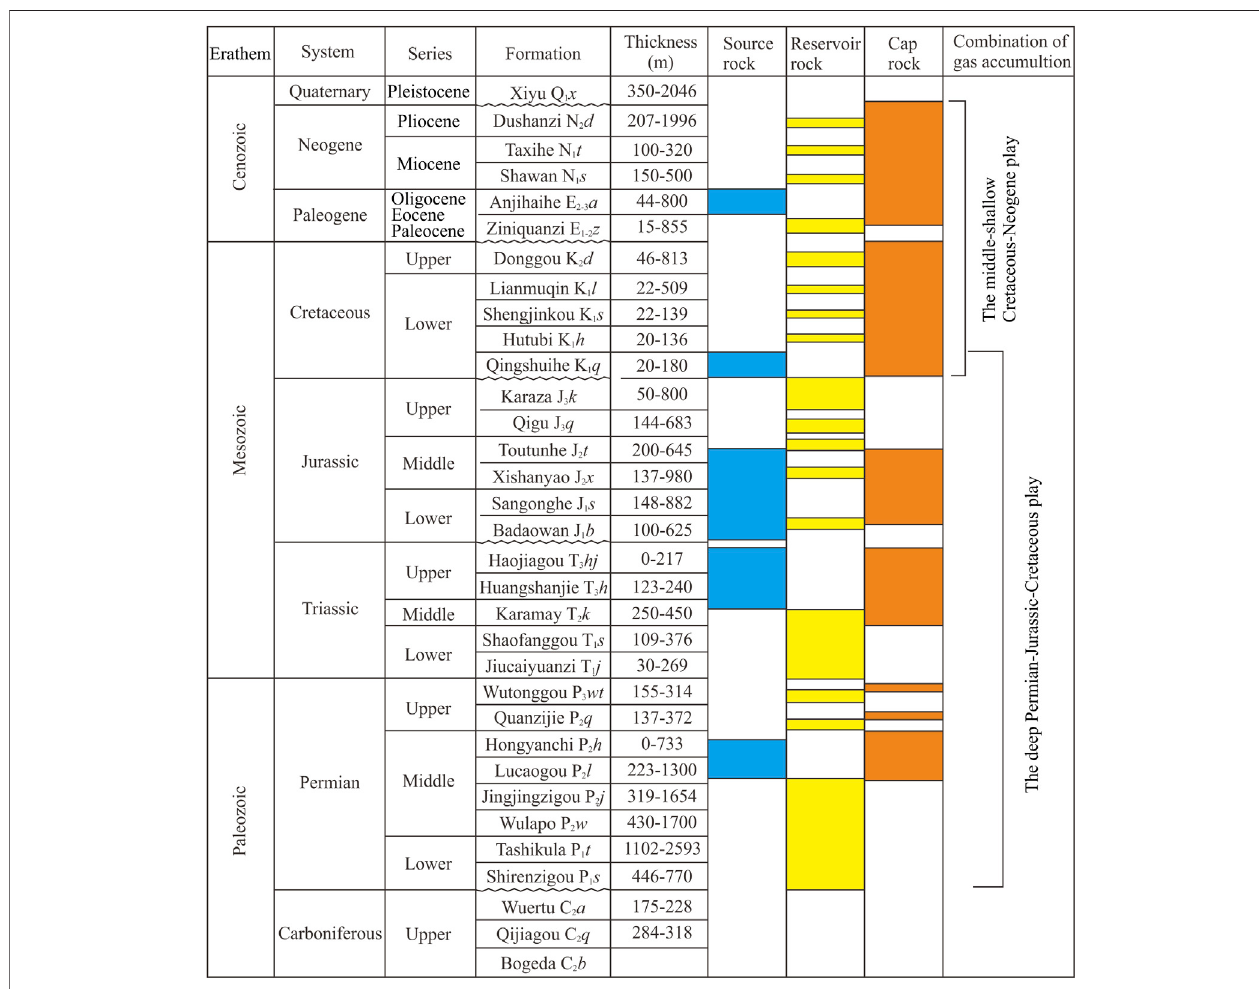
FIGURE 2 | Sedimentary strata as well as combination of source rock, reservoir rock, and cap rock in the southern margin of the Junggar Basin.